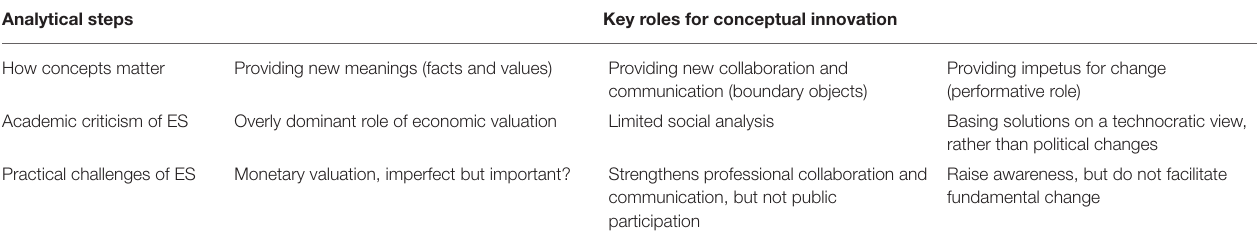
TABLE 1 | Summary of key findings on conceptual innovations for transformative